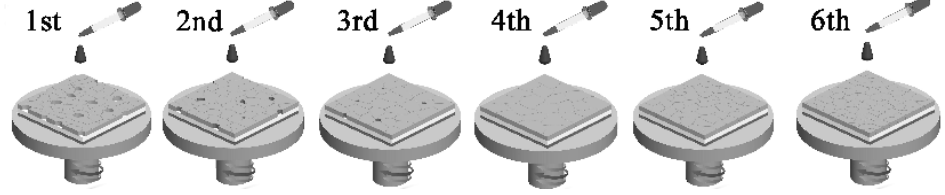
Figure 3. Schematic illustration diagram of multi-step spin-coating of CsBr solution [33].